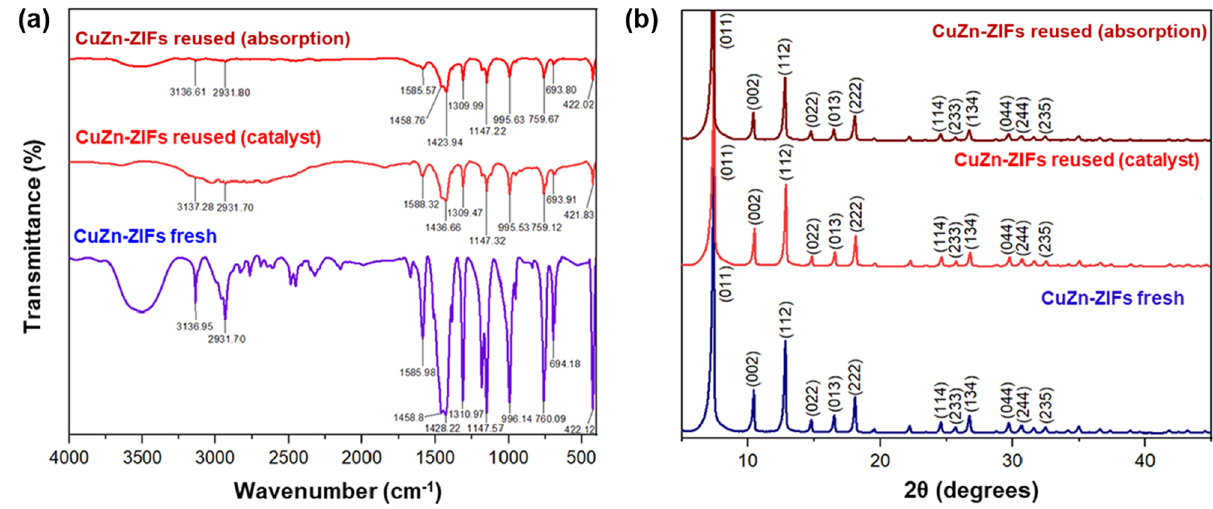
Figure 10: Structure analysis of CuZn - ZIFs reused after multiple cycles: ( a ) FT - IR pattern of CuZn - ZIFs reused and ( b ) PXRD pattern of CuZn - ZIFs